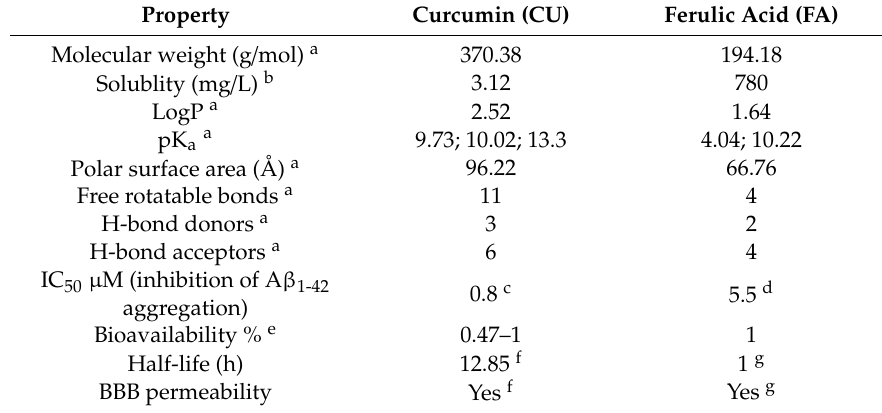
Table 2. Physicochemical and ADME (adsorption, distribution, metabolism and excretion) properties of curcumin (CU) and ferulic acid